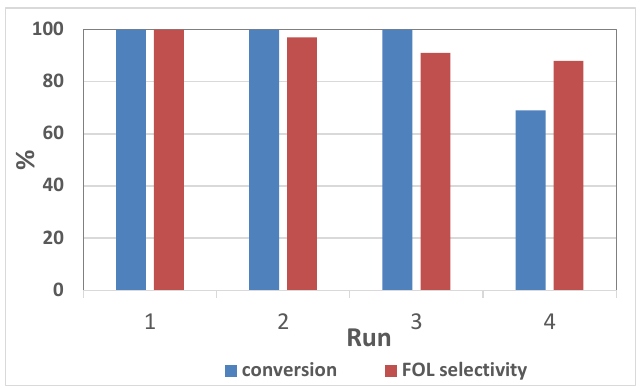
Figure 3. Recycling of Co/SiO 2 . 1 g of furfural, 9 g of ethanol, T = 150 °C, 20 bar of hydrogen, 1 h of reaction.